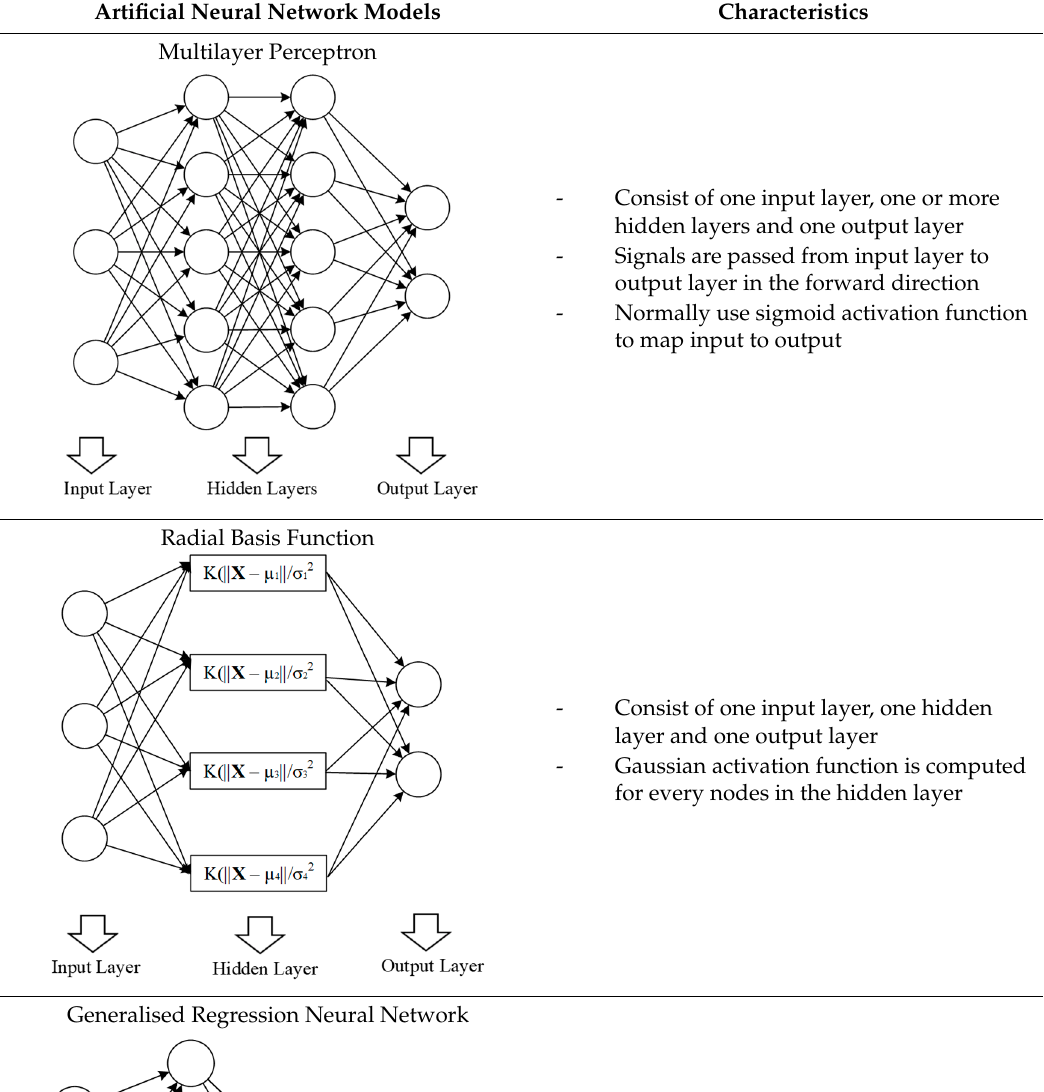
Table 3. Characteristics of artificial neural network models.